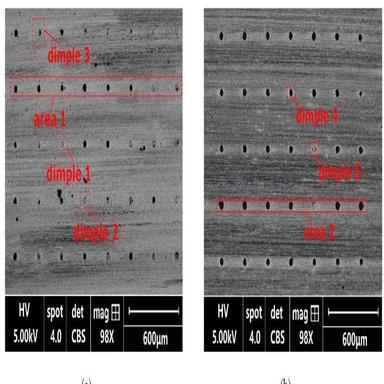
BSE images of the textured counter-surface with medium coverage (1.6%) of Type A (wide & deep) dimples in (a) run-in stage and (b) steady wear stage.